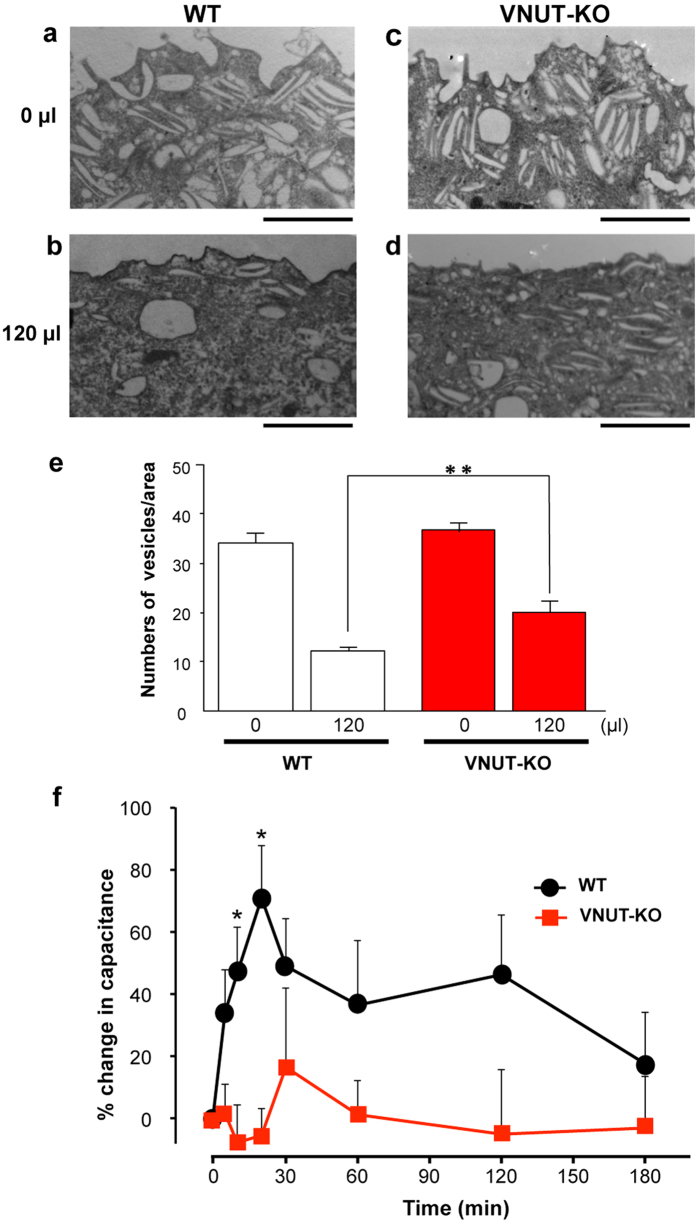
Anatomic and functional analysis of urothelial membrane trafficking.(a–e) Transmission electron microscopic analysis of the umbrella cells apical poles in the WT and VNUT-KO mouse bladder. WT (a,b) and VNUT-KO (c,d) mice were catheterized, and the urine contained in the bladder was drained. After incubation for 30 min, control bladders (a,c), for which no saline was added, and the saline-filled bladders (b,d), which were filled with 120 μl of normal saline at a rate of 1.6 μl/min, were processed and imaged. Scale bar, 2.0 μm. (e) The number of FDVs in randomly placed 2 μm radius circles in the apical cell layer. Data are the mean ± SEM. **P < 0.01 (Student’s t-test). (f) The time-course of changes in membrane capacitance with hydrostatic pressure measured by an Ussing chamber. Isolated mouse bladder tissue was exposed to pressure across the mucosal side at t = 0 and the capacitance was recorded. Values show mean changes in capacitance ± SEM (WT, n = 7; VNUT-KO, n = 4). Asterisks show significant differences in capacitance between WT and VNUT-KO bladders (*P < 0.05).